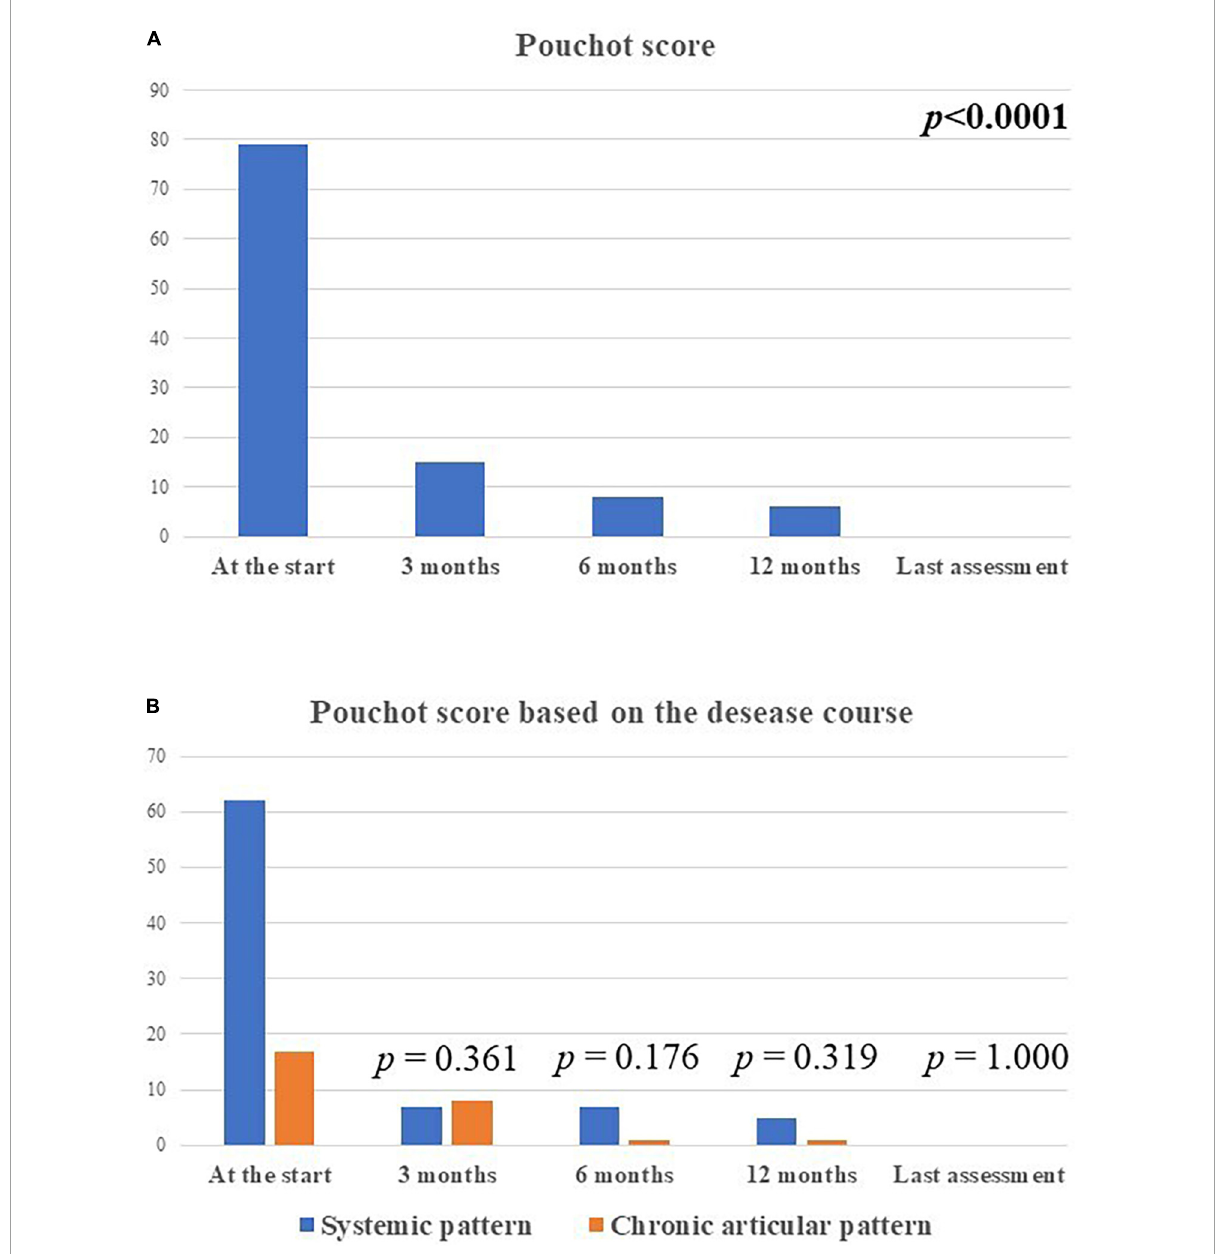
FIGURE5 The total amount of the modified Pouchot score in the whole group of patients enrolled (A) and according with the disease course (B) at the different time-points. The total amount of the systemic modified Pouchot score was higher among patients with the systemic Still’s disease in relation with the higher systemic involvement in this patients compared to the chronic-articular